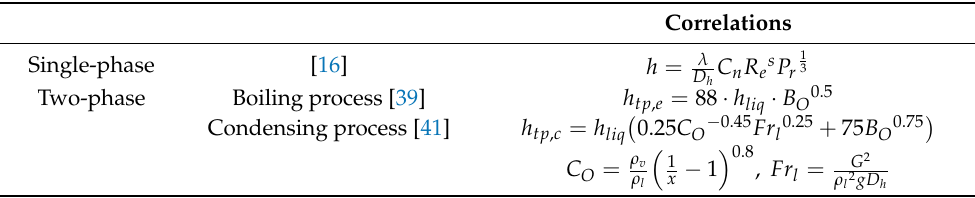
Table 7. Heat-transfer coefficient equations for heat exchangers.